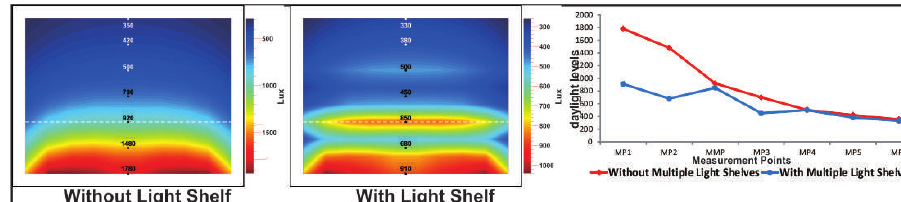
Fig. 13. Comparison of light distribution at 3 p.m.